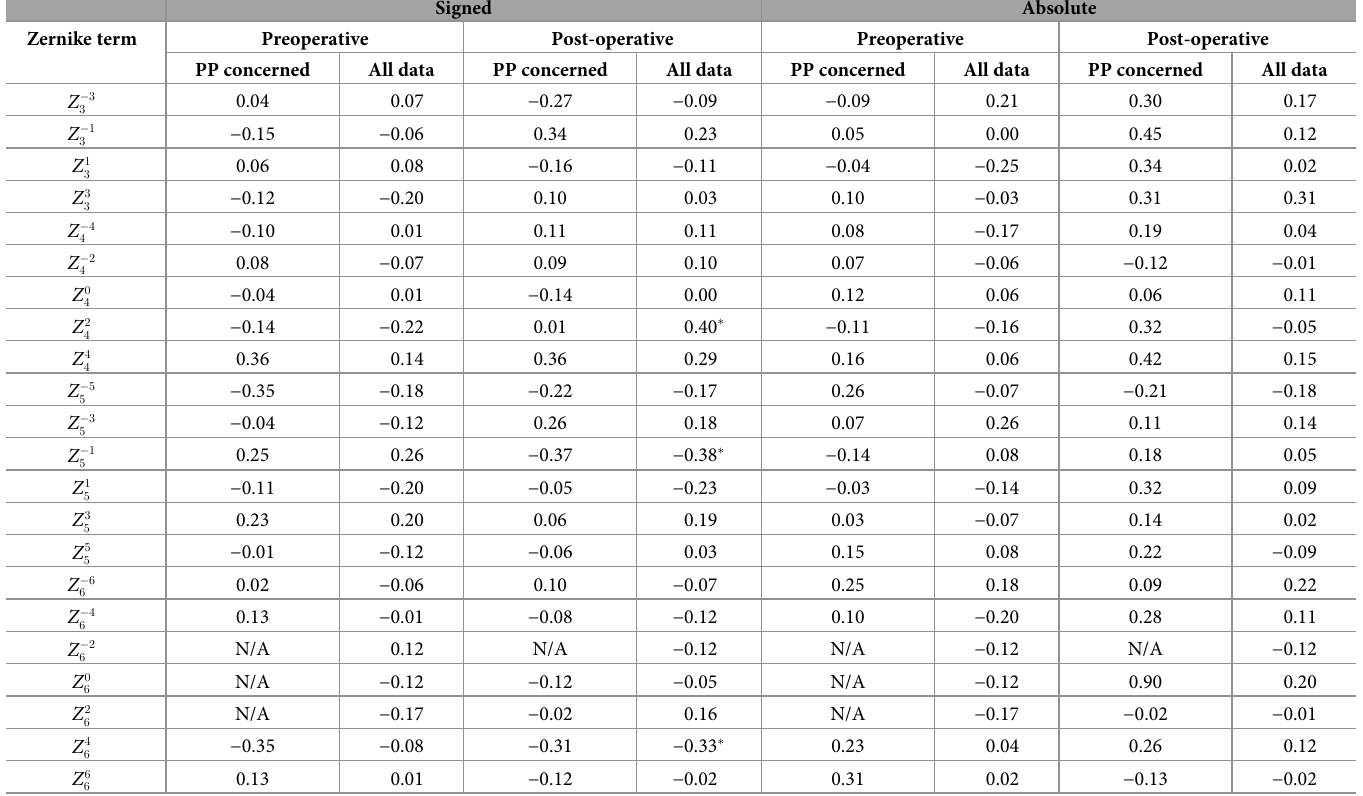
Table 2. Statistical correlation between photophobia scores and signed and absolute coefficients of each Zernike term.